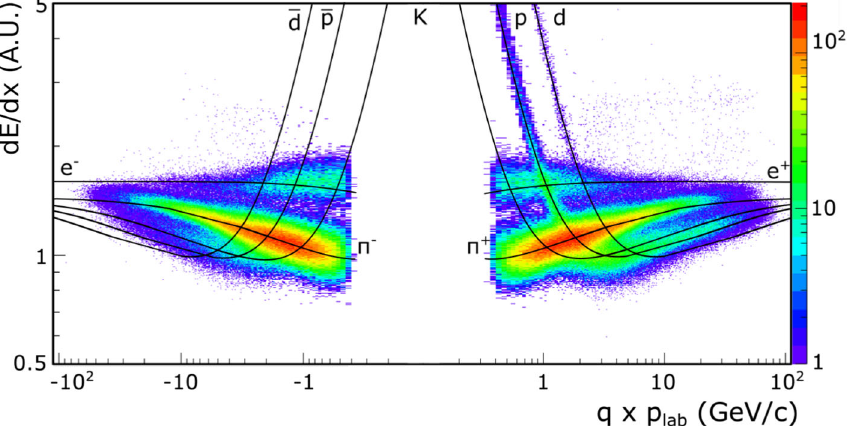
Fig. 7 Distribution of charged particles in the d E / d x – q · p lab plane. The energy loss in the TPCs for different charged particles for events and tracks selected for the analysis of Be+Be collisions at 75 A GeV / c